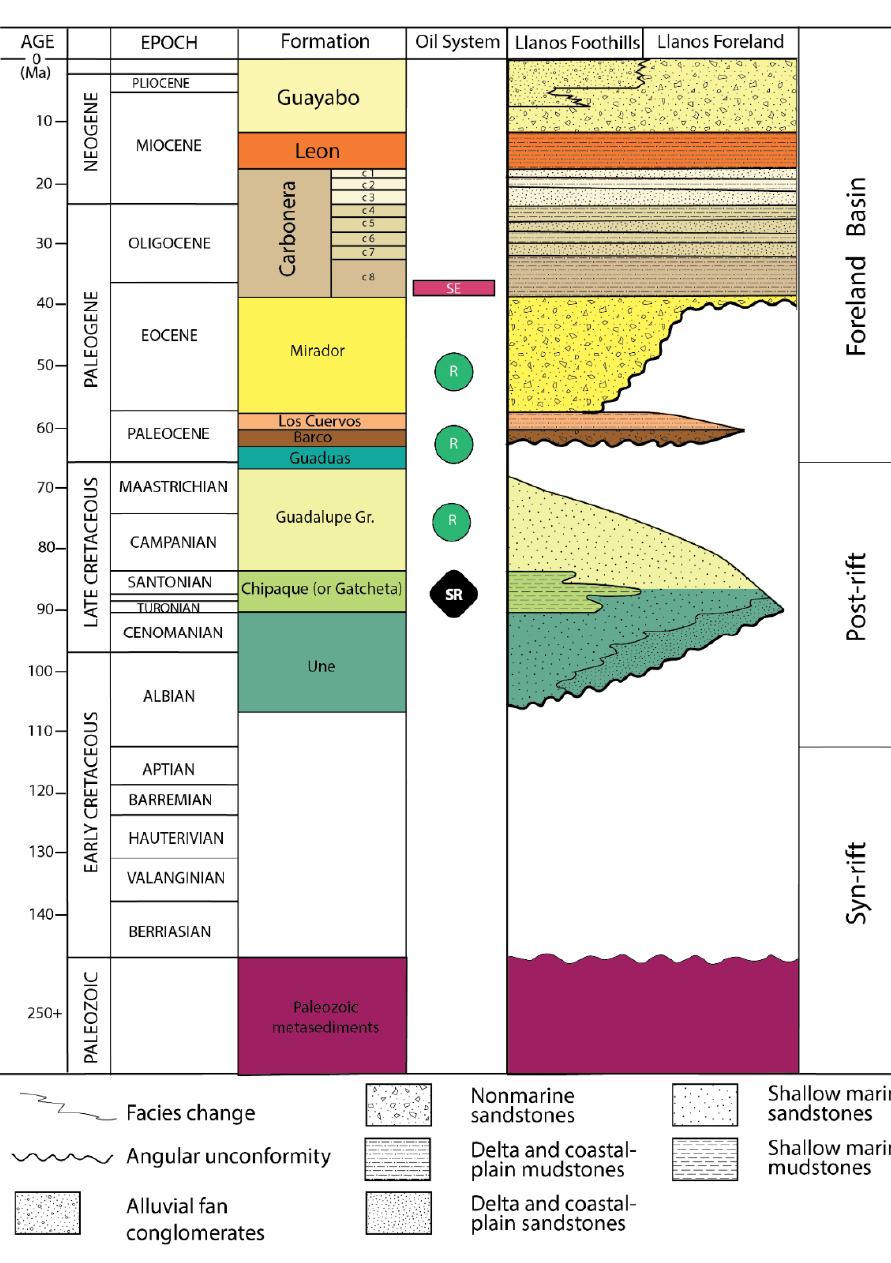
Figure 2. Chronostratigraphic diagram of Paleozoic–Cenozoic strata in the Llanos foothills (after Ramon and Fajardo, 2006; Parra et al., 2009).